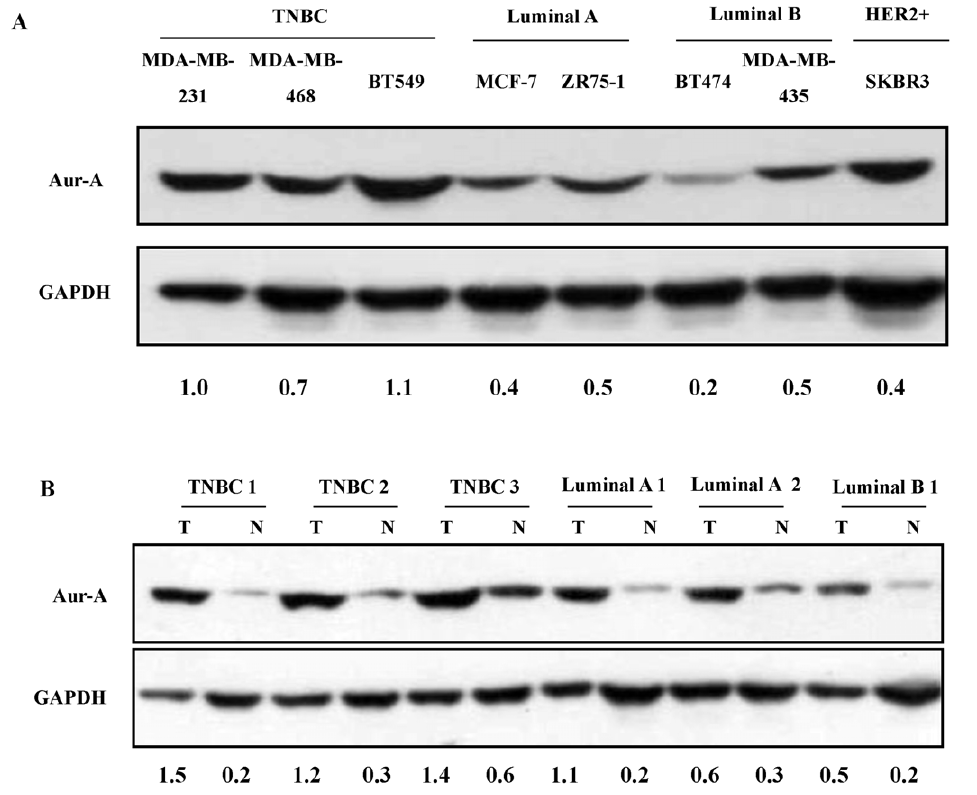
Figure 4. Aur-A was overexpressed in breast cancer cell lines and primary samples. (A) Western blot analysis of Aur-A expression in breast cancer cell lines. (B) Western blot analysis of Aur-A expression in breast cancer samples.